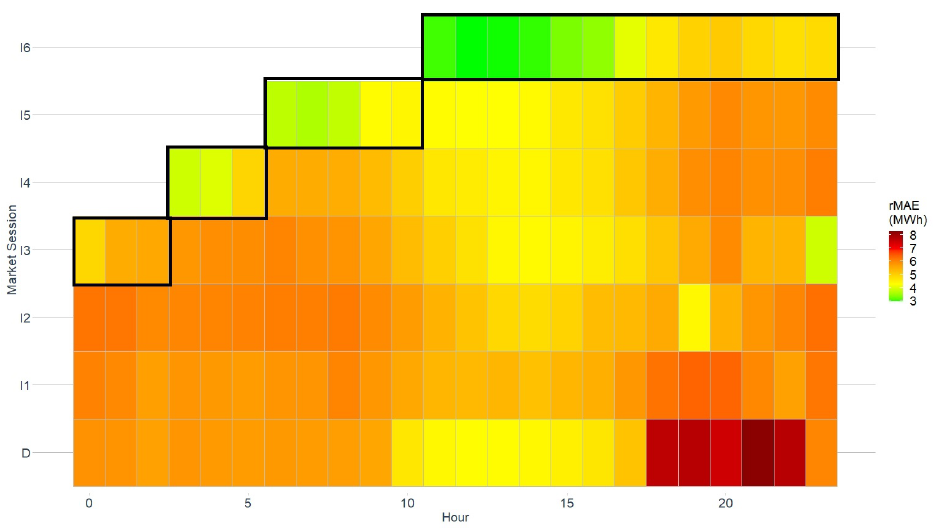
Figure 7. Error evolution by market